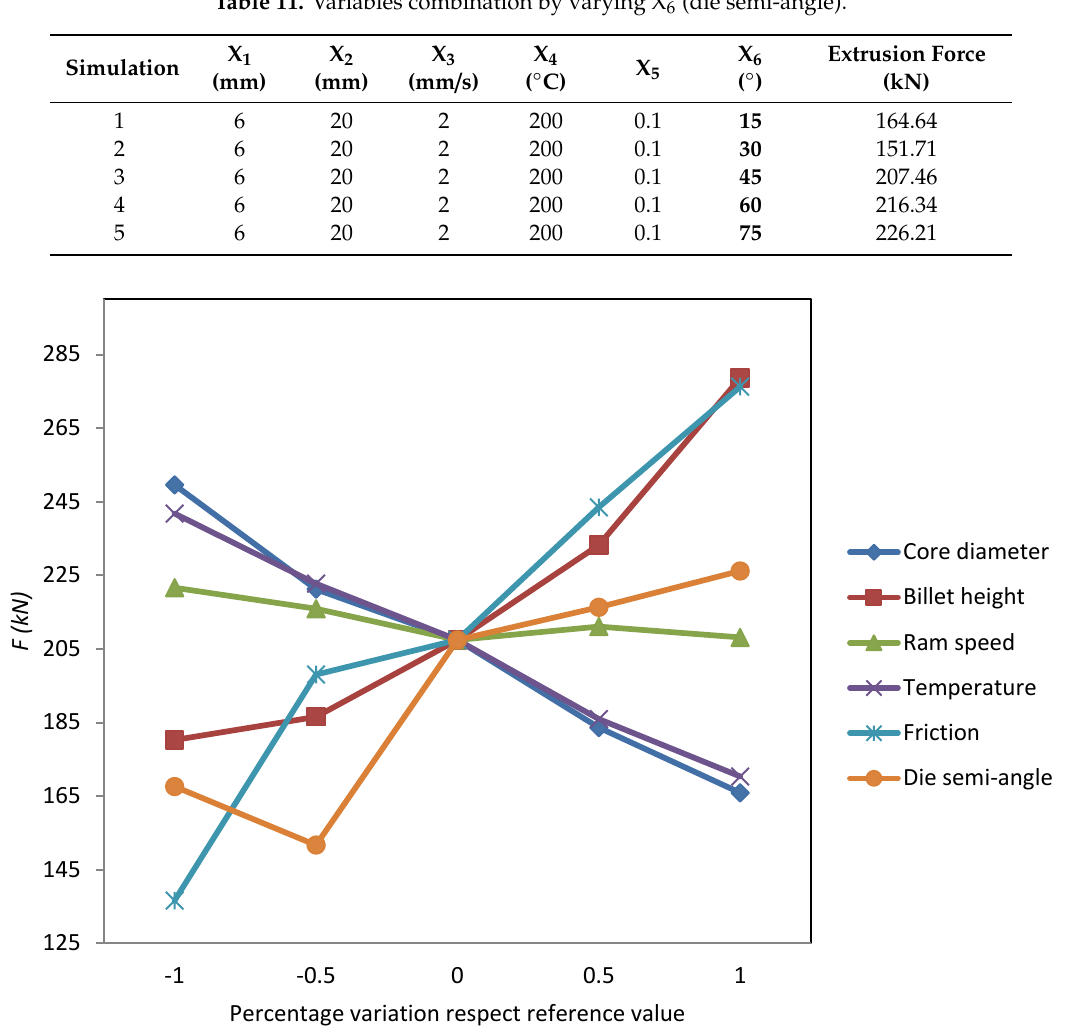
Figure 8. Perturbation chart of the bimetallic extrusion process.